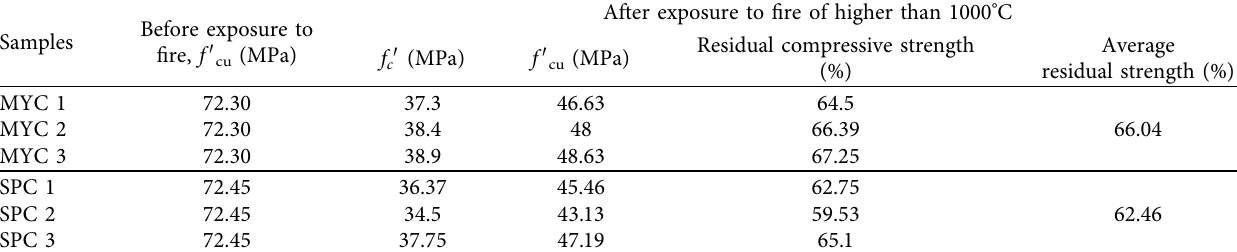
Table 3: Compressive strength of the MYC and SPC concrete segments.